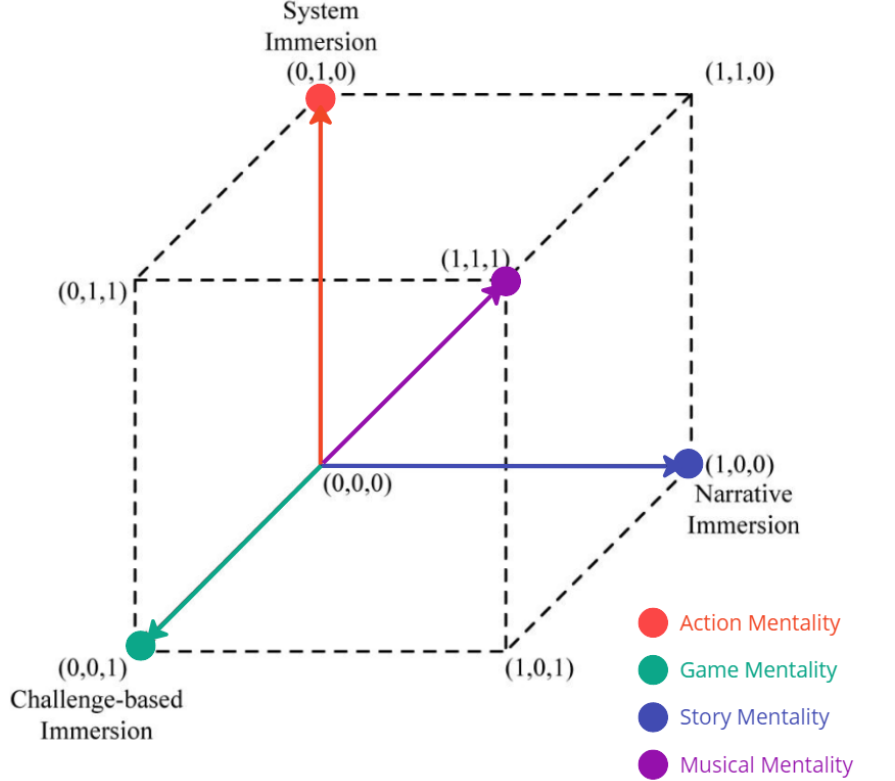
Figure 7. Translation of the mentalities identified in our analysis of Beat Saber and Ragnarock to the 3-axis taxonomy of immersion from Nilsson (2016). The Action, Game and Story mentalities map directly to System, Challenge-based and Narrative immersion respectively. The Musical mentality in a rhythm game can be considered immersive across all 3